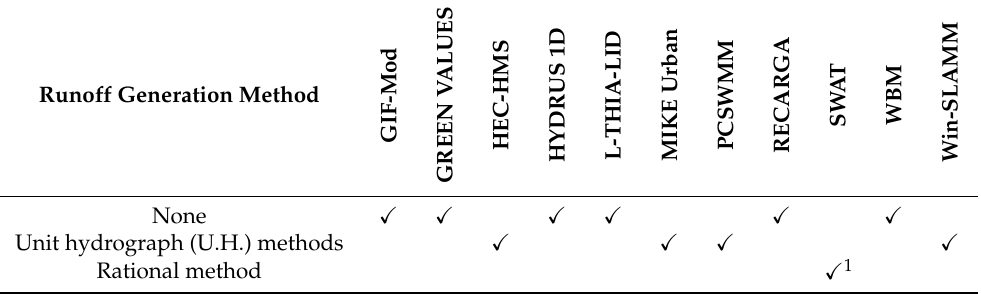
Table 8. Comparing the methods for generating the runoff hydrograph and peak in the selected models.